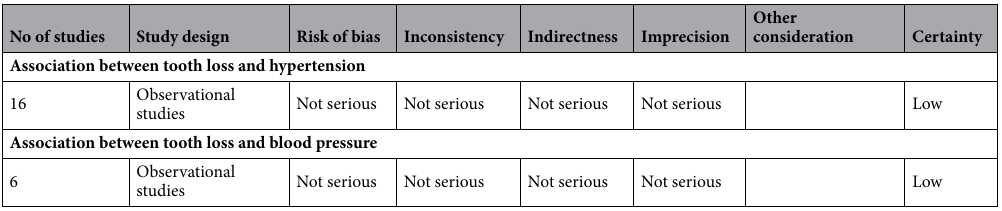
Table 3. Summary of evidences according to GRADE